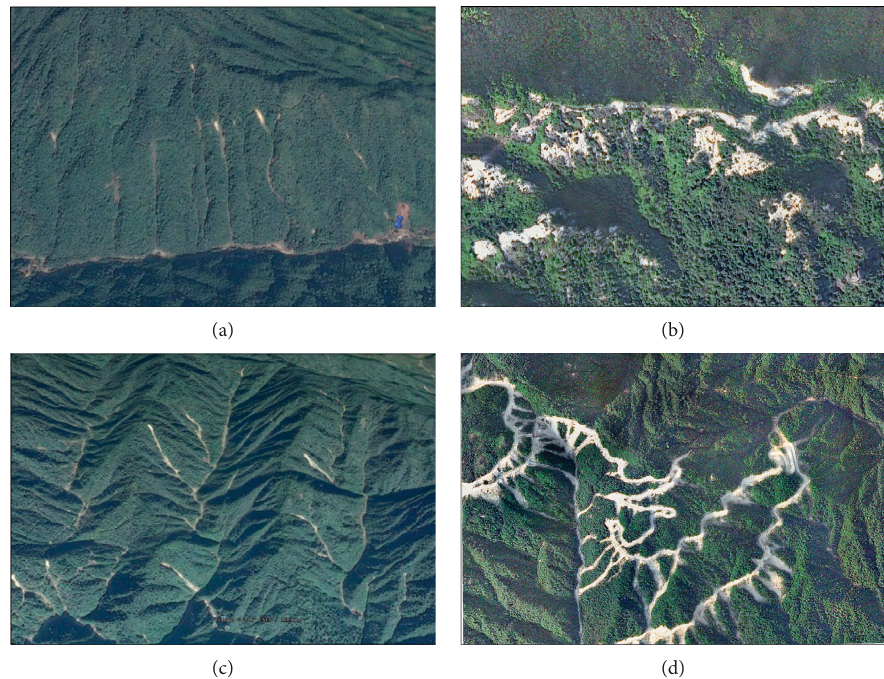
Figure 3: The soil erosion types of NNNR: (a) rill erosion along a slope, (b) sheet erosion mainly along mountain ridge lines, (c) gully erosion along the gully, and (d) human-induced erosion. The green colour in each photo is the vegetation cover.